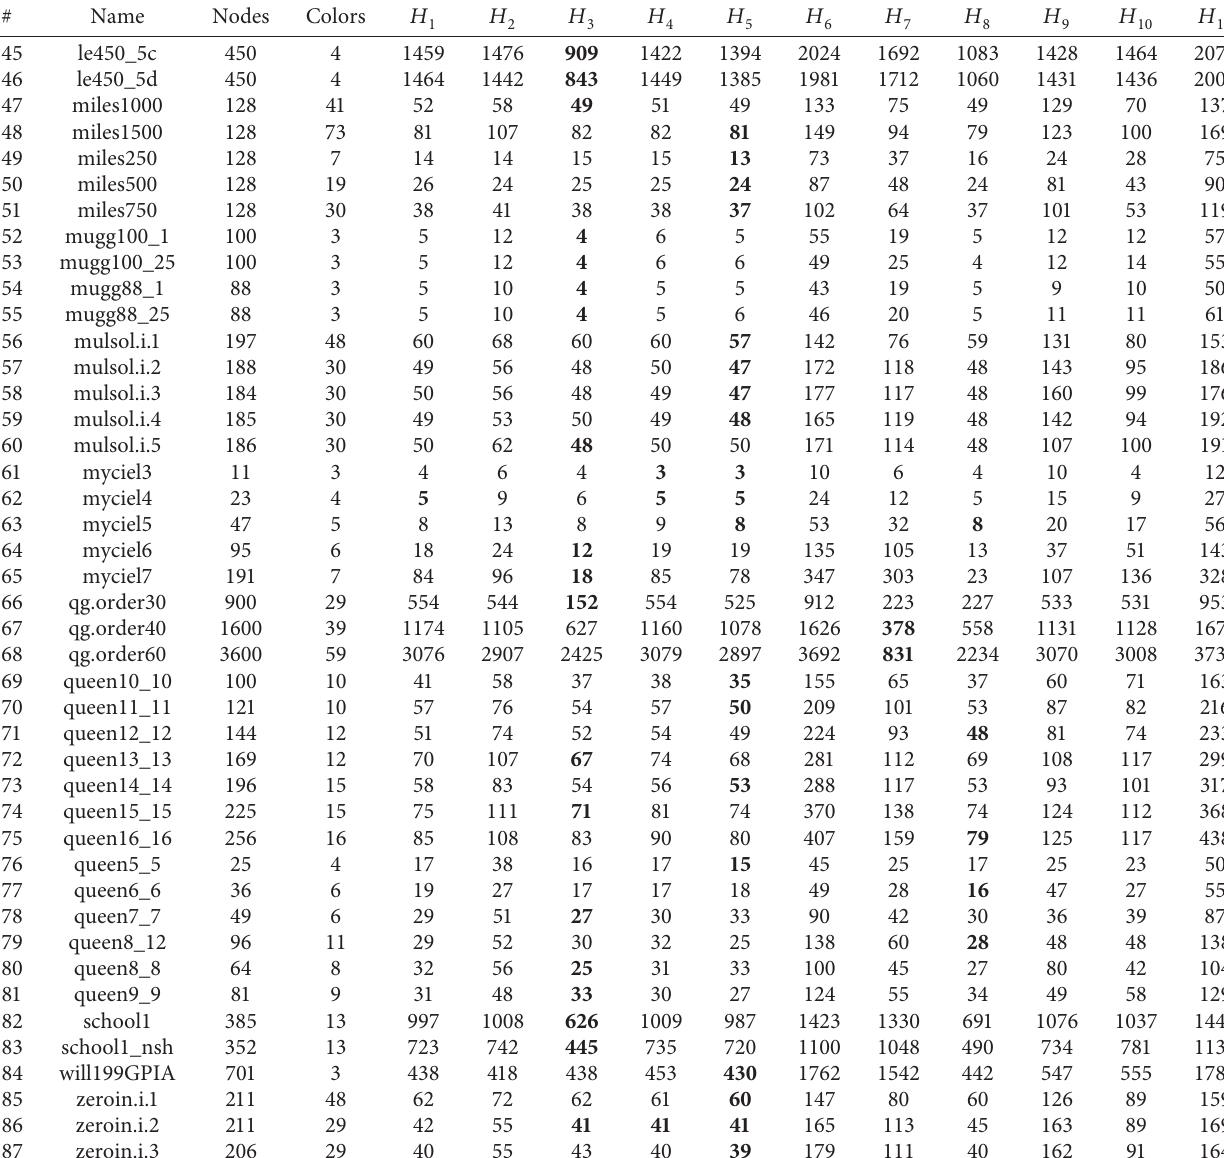
Table 6: Heuristics results for graph coloring instances.